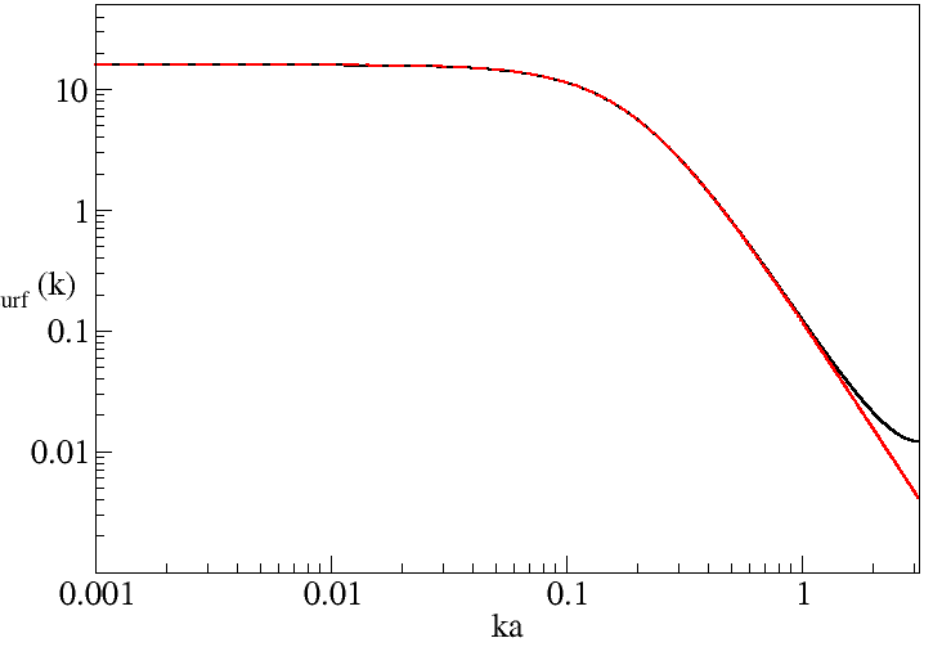
Figure A1. Comparison of the power spectrum obtained from a finite system with N = 4096 points and the continuous, analytic, spectrum as a function of dimensionless wave